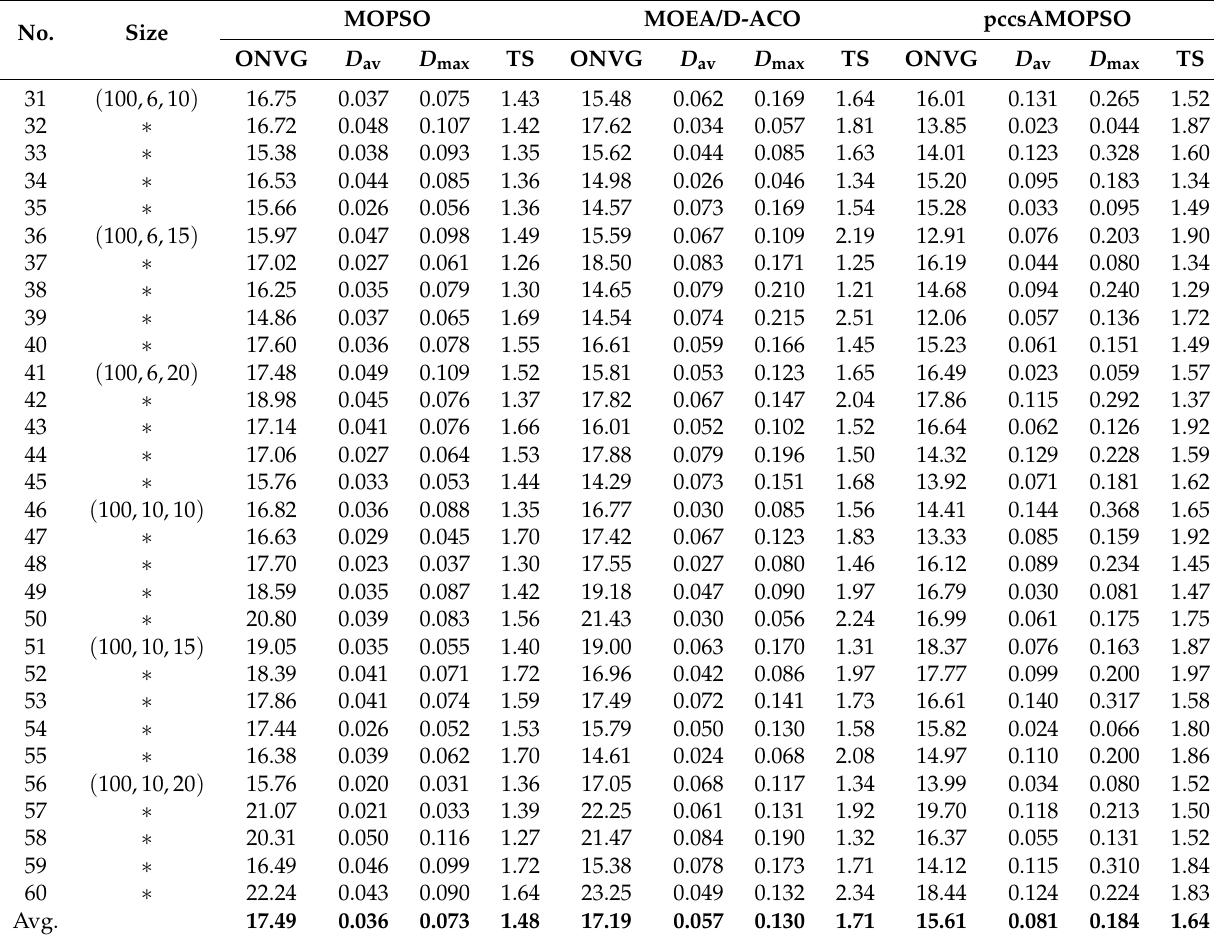
Table 5. Comparison of MOPSO with MOEA/D-ACO and pccsAMOPSO on the test instances with 100 cars.